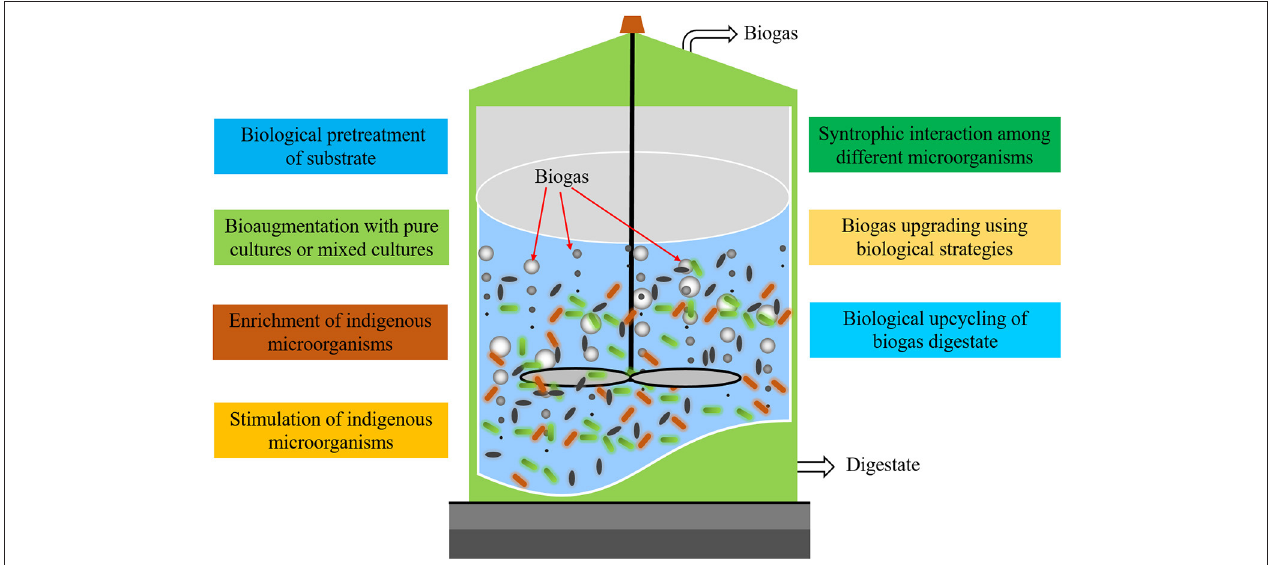
FIGURE 1 | Biological strategies to enhance the anaerobic digestion